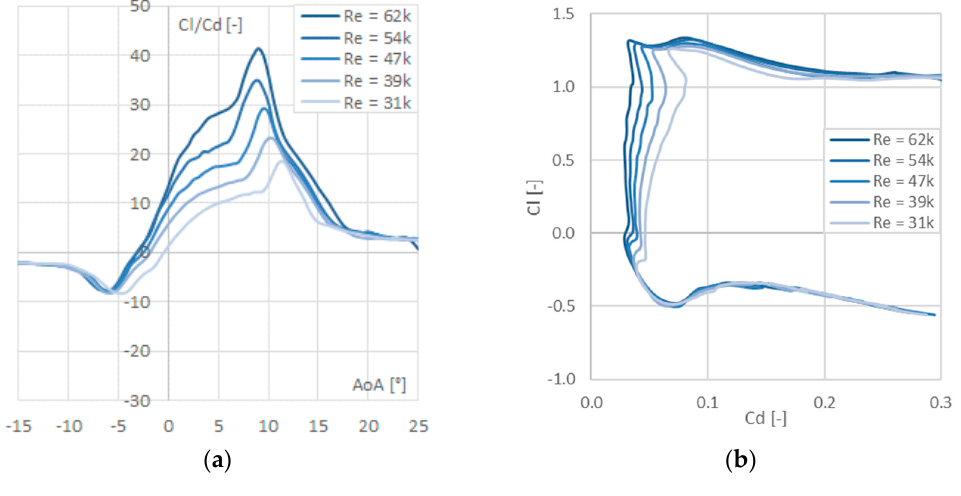
Figure 2. S826 aerofoil polar plots: Cl/Cd ( AoA ) ( a ) and Cl ( Cd ) ( b ).